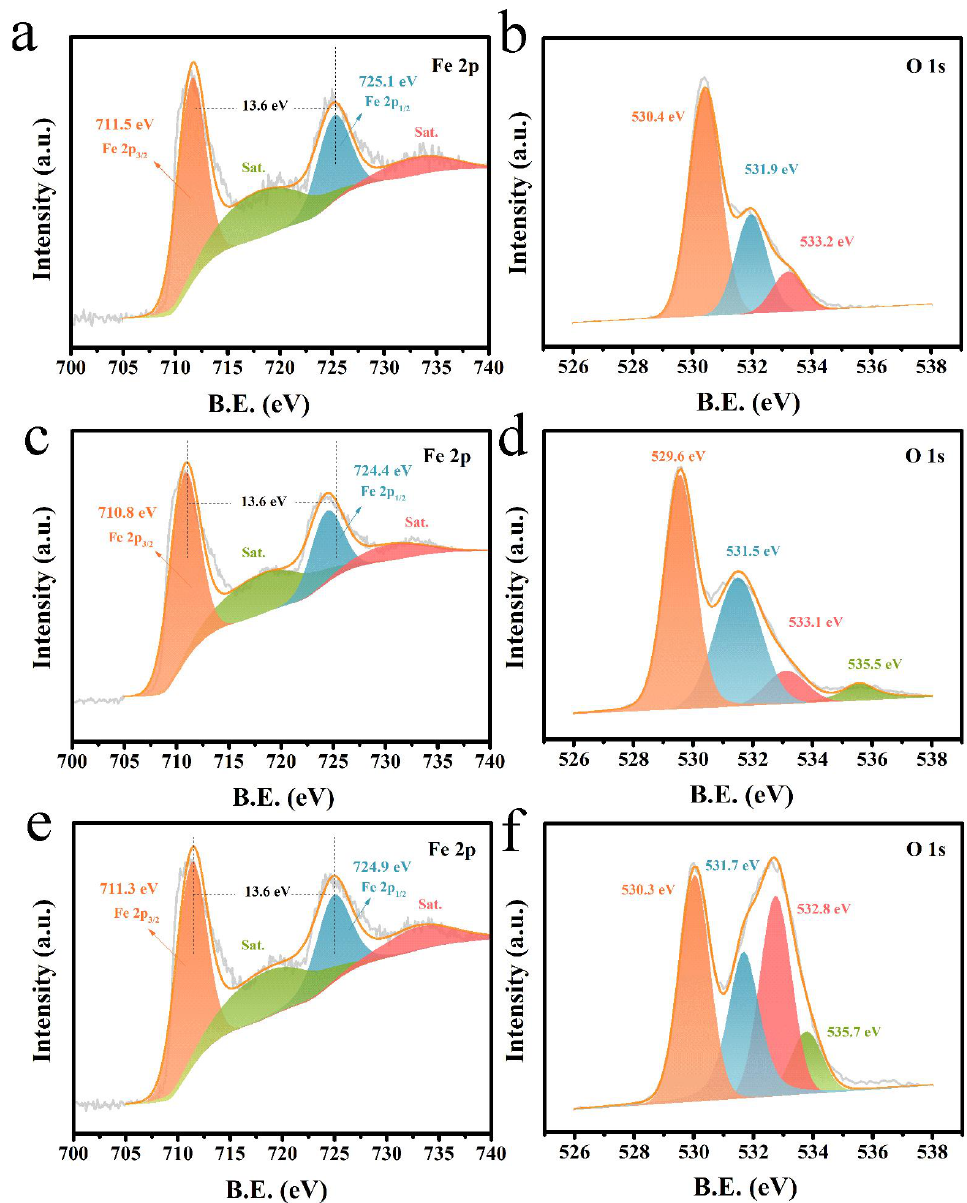
Figure 2. The XPS spectra of Fe 2 O 3 /CC for ( a ) Fe 2p and ( b ) O 1s regions. The XPS spectra of D-Fe 2 O 3 /CC for ( c ) Fe 2p and ( d ) O 1s regions. The XPS spectra of D-Fe 2 O 3 @PPy/CC for ( e ) Fe 2p and ( f ) O 1s regions.